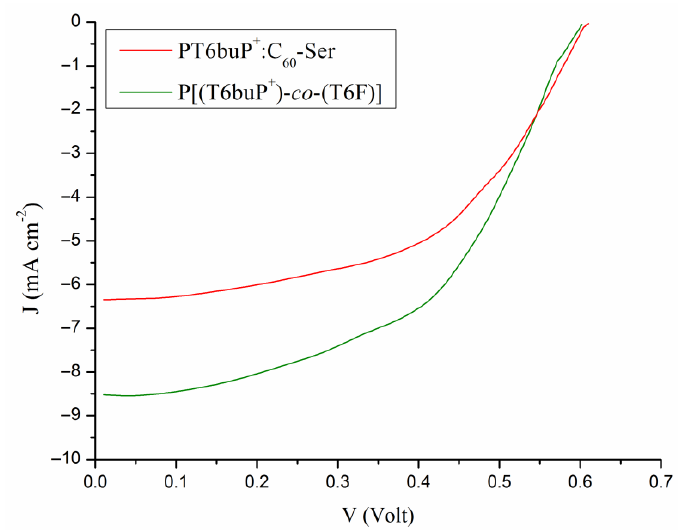
Figure 6. Current density–voltage for the best-performing cells tested under AM 1.5 one-sun illumination.